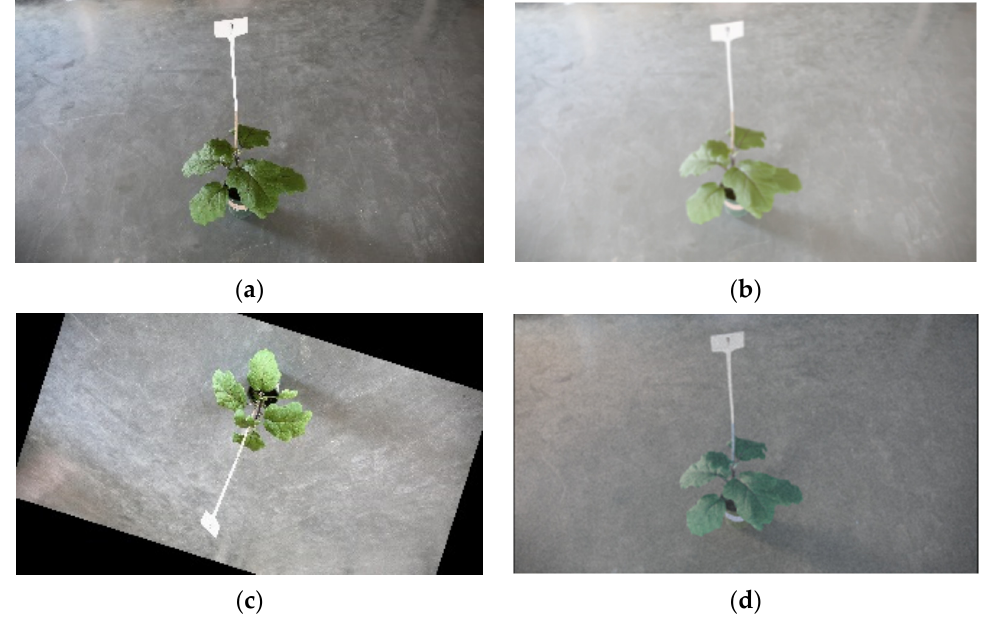
Figure 5. Image augmentation by: ( a ) original image; ( b ) adjust brightness; ( c ) rotation; ( d ) increase noise.